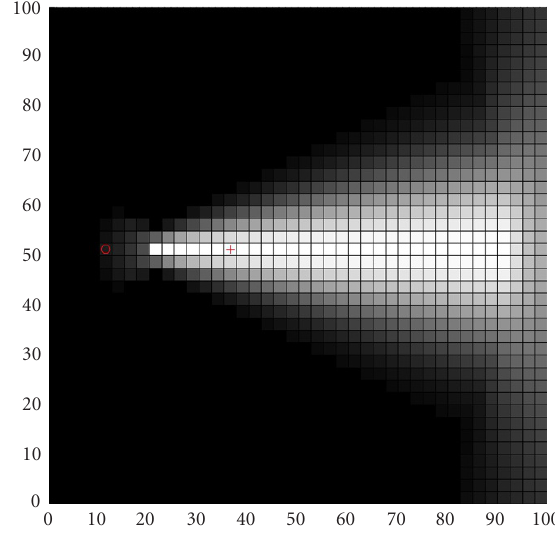
Figure 7: Likelihood function p ( z | x ). The circle is the sensor loca- tion and the cross is the target location. The standard deviation of the Gaussian distribution is as in Figure